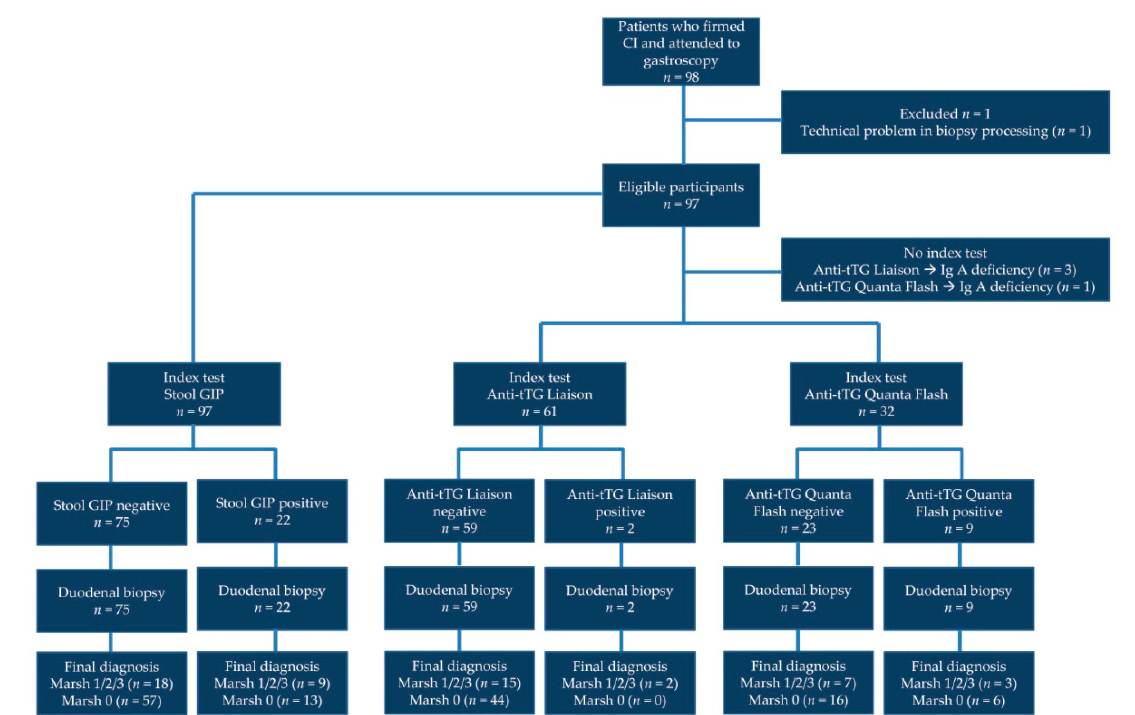
Figure 1. Flowchart of participants through the study.